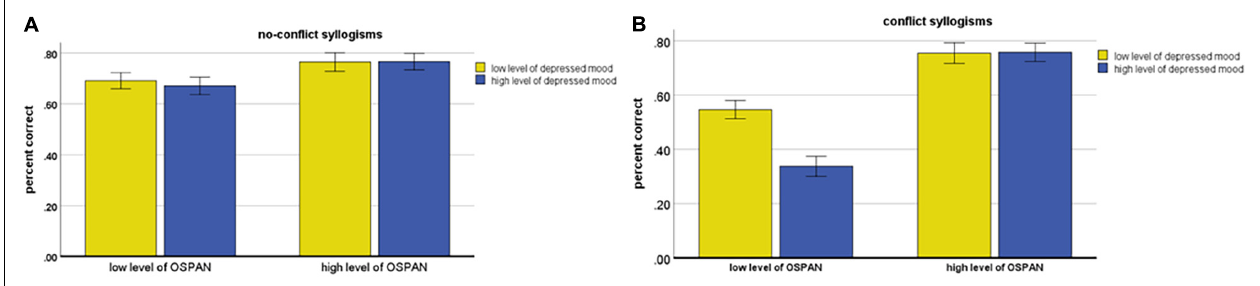
FIGURE 4 | Accuracy of syllogistic reasoning as the function of Depressed mood and OSPAN for no-conflict syllogisms (A) and conflict syllogism tables (B) . Error bars represent the standard errors of the mean.